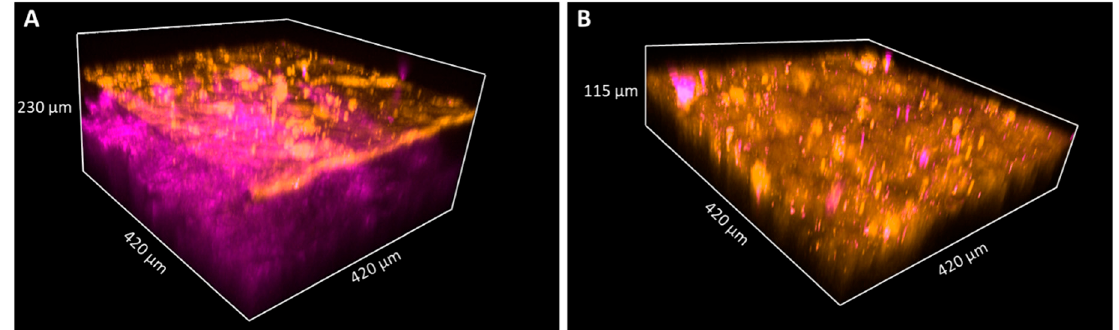
Figure 6. TPF and SHG images of keratin and collagen in 3D images of skin biopsies of healthy subject ( A ) and palmoplantar keratoderma ( B ). Penetration depth of the pump laser markedly decreases if the epidermis expands; thus, the papillary dermis could not be reached in the case of keratoderma. The size of the images as follows: 420 × 420 μ m.